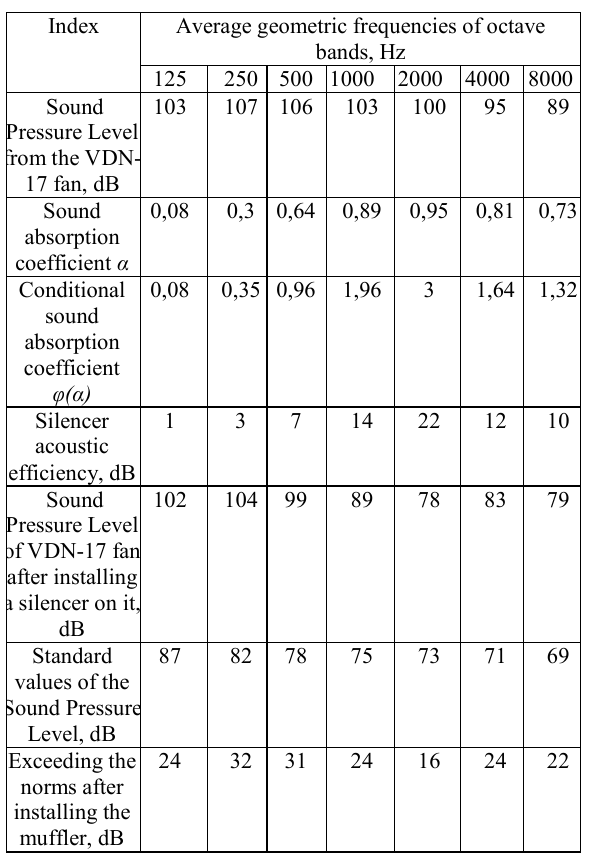
Table 5. Results of calculating the effectiveness of measures for installing a basalt fiber muffler in the measurement zone around the body